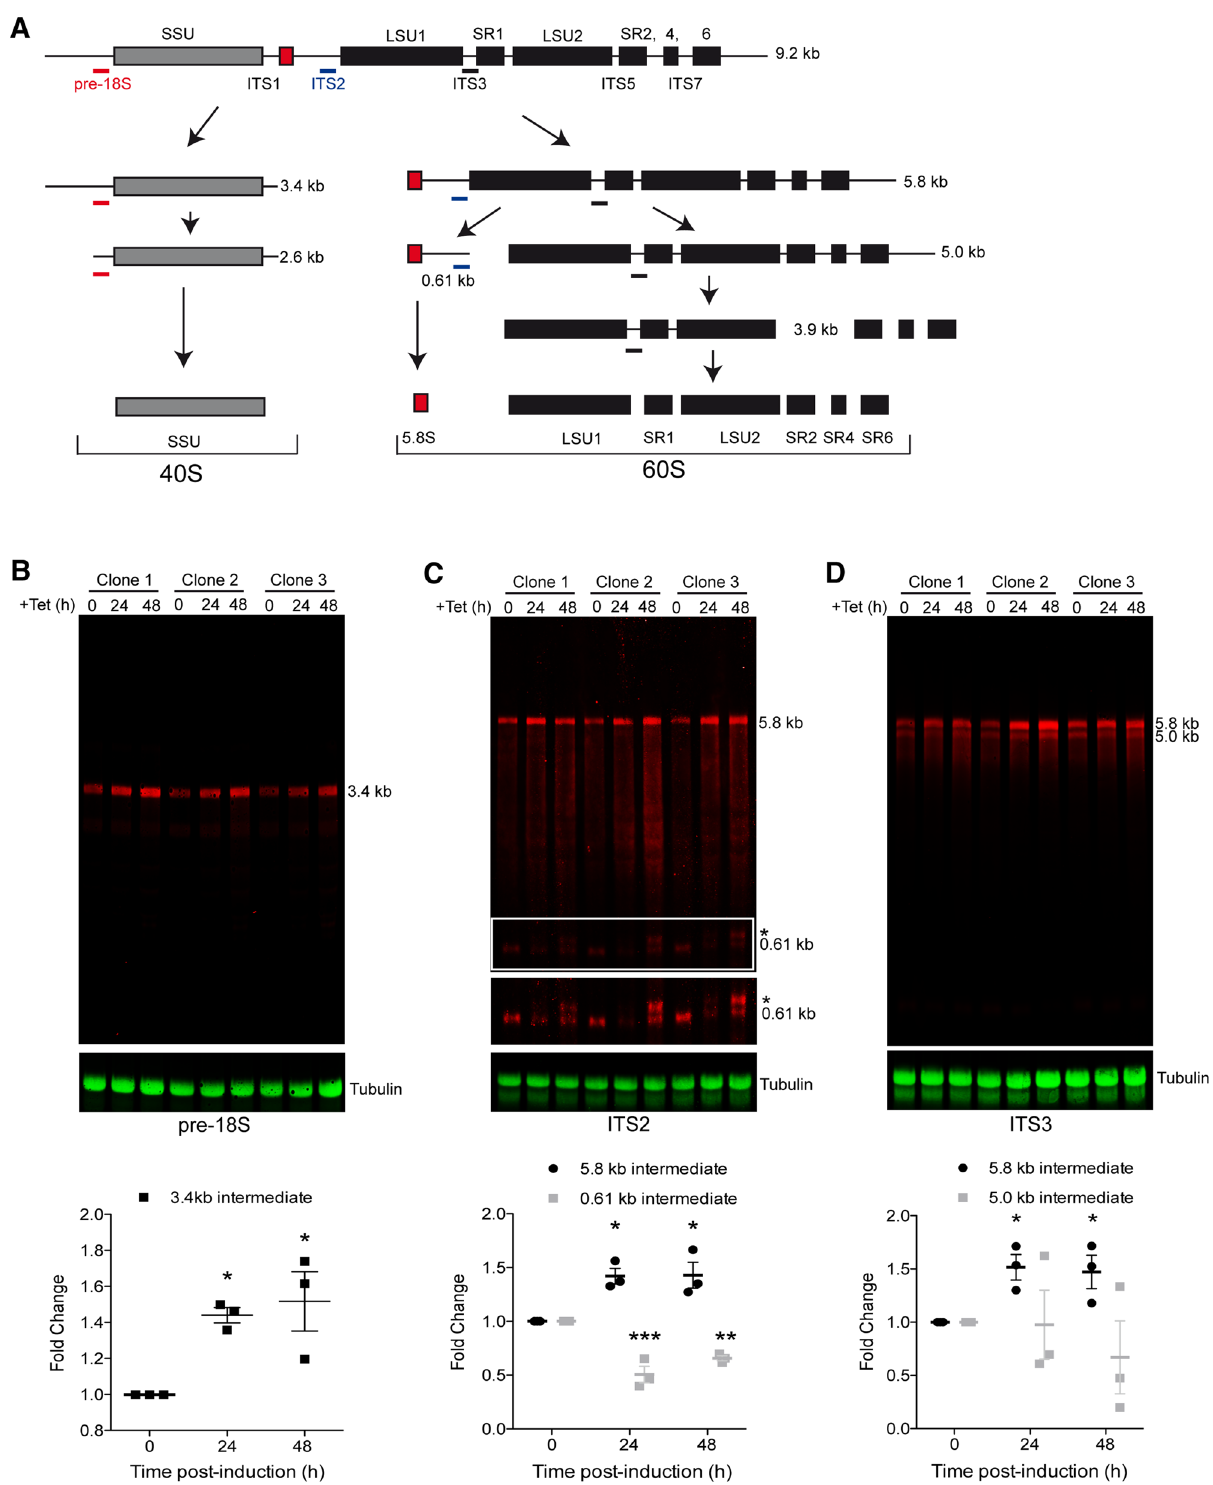
Figure 4. Knockdown of Hel66 results in accumulation of rRNA processing intermediates. ( A ) Schematic of the rRNA processing pathway in trypanosomes. Probe positions are indicated as thick lines in red, blue and black for the pre-18S, ITS2 and ITS3 probes, respectively. The figure is based on analysis of stable processing intermediates from previous studies 13,17,44 . ( B–D ) Northern blots loaded with total RNA from cells induced for Hel66 RNAi for 0, 24 and 48 h were probed with pre-18S ( B ), ITS2 ( C ) and ITS3 ( D ) and for tubulin (loading). The experiment was performed with three different clonal cell lines. Averages of the three clones normalised to tubulin with error bars representing standard error of the mean are shown below. The 0.61 kb band and its precursor (white frame) are shown with increased contrast underneath the blot ( C ). The novel processing intermediate of the 5.8 S rRNA is marked with an asterisk. Differences to the uninduced cells were considered statistically significant, when the P -value was smaller than 0.05 (one-way ANOVA and Dunnette’s Post-hoc test; * represents P < 0.05, ** P < 0.01 and *** P <